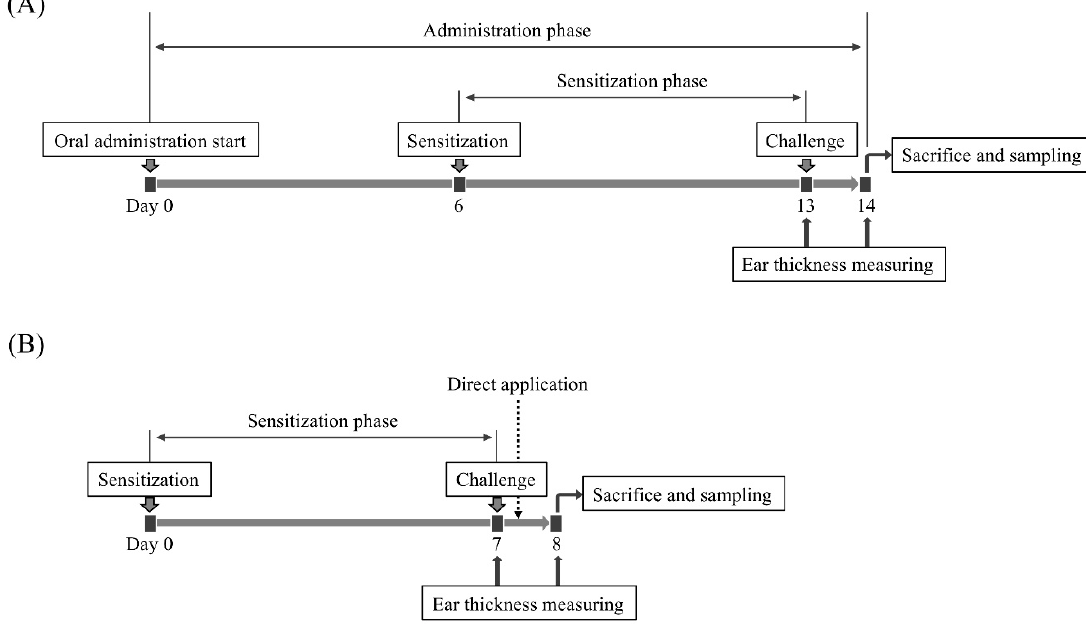
Figure 7. Outline of the animal experiment. Mice were sensitized with PiCl 7 days before the allergen challenge. ( A ) After a one-week acclimation period, 200 µ L of each sample was orally administered once a day during the experimental period until sacrifice. At day 13, the mice were challenged via the ear with PiCl. After 24 h, the mice were sacrificed. ( B ) Instead of oral administration, each sample was directly applied to the ear lobe after 2 h of the allergen challenge.